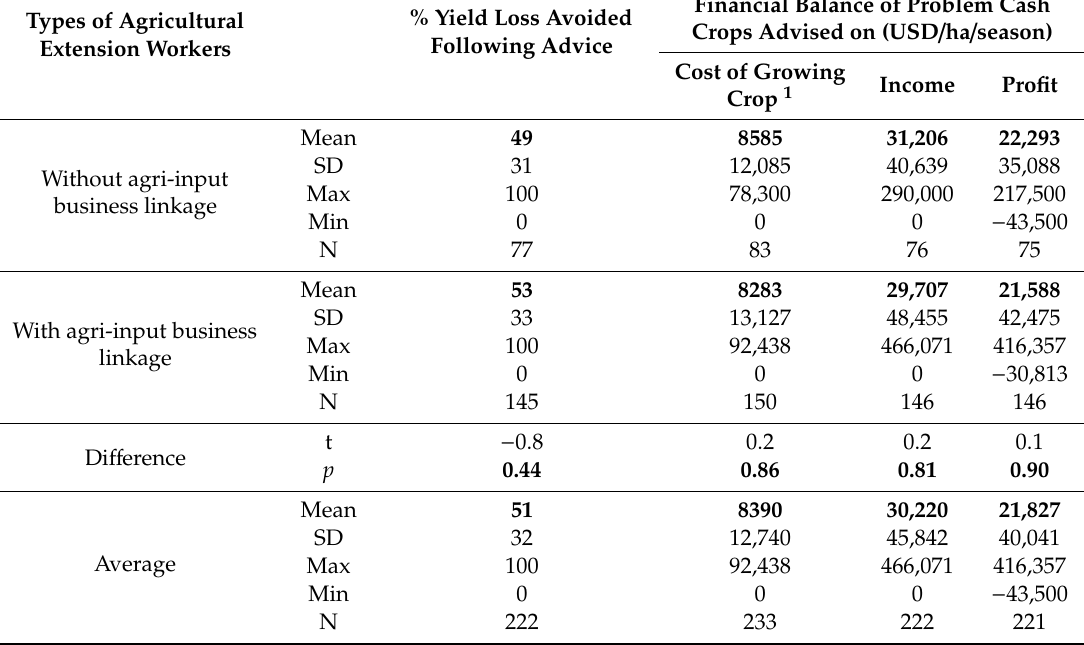
Table 2. Financial balance for cash crops advised on by agri-input-business-linked or non-business-linked agricultural extension workers (here plant doctors) in Beijing municipality in 2016, N represents each sample sizes of the 263 growers interviewed (differences according to independent samples t-test at p <